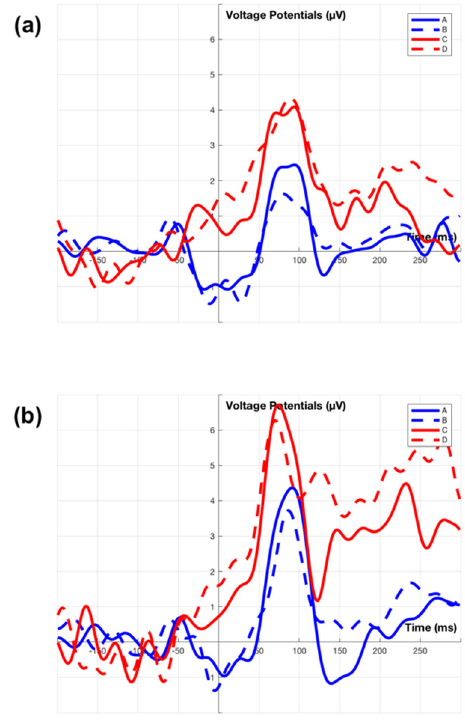
Figure 9. Grand average ERP of channel ERP plots. Plot ( a ). Grand average ERP of channel P7. Plot ( b ). Grand average ERP of channel P8. Signal A, B, C, D is consistent with Figure 7.